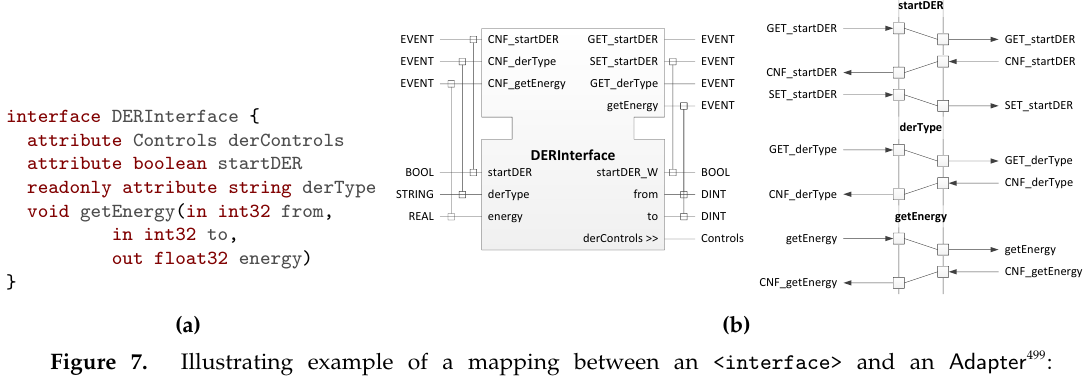
Figure 7. Illustrating example of a mapping between an <interface> and an Adapter 499